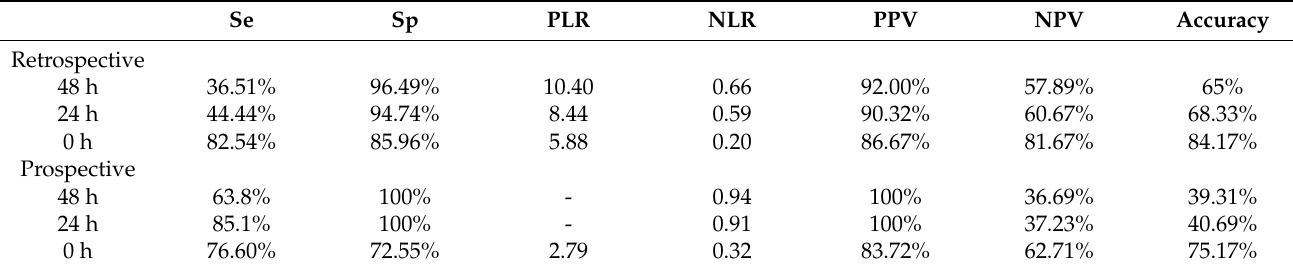
Table 7. Diagnostic ability of the Sepsis Prediction Score ≥